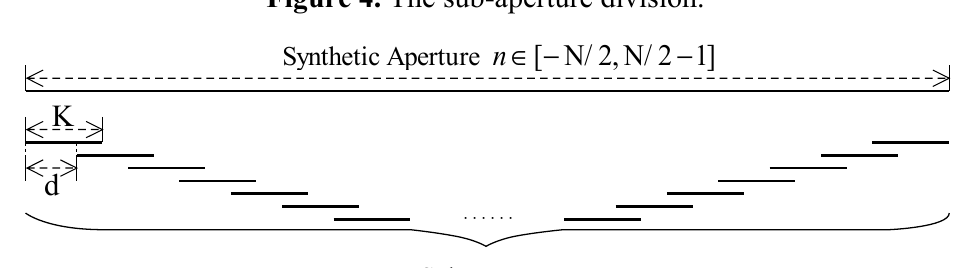
Figure 4. The sub-aperture